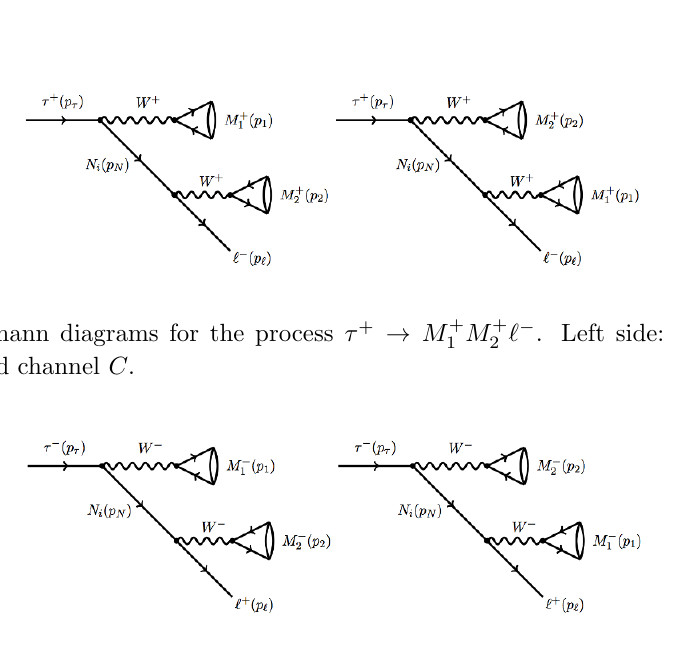
Figure 2 . Feynmann diagrams for the process (cid:28) (cid:0) ! M (cid:0) Right side: crossed channel C